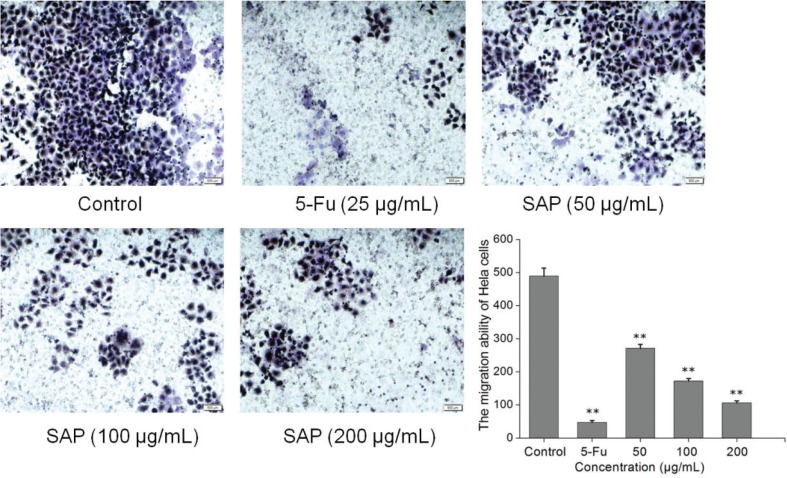
The effect of SAP restrains tumor migration ability of Hela cells. Typical photos and quantification of the transwell migration assay with Hela cells co-cultured with SAP or 5-Fu. The results were expressed as means ± SD (n = 3). **p < 0.01 compared with control group.